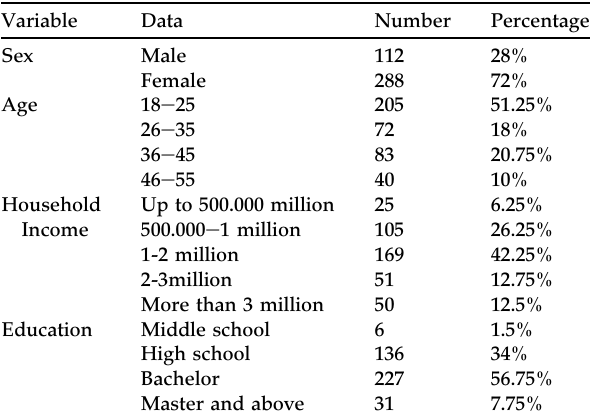
Table 1. Participant ' s demographic